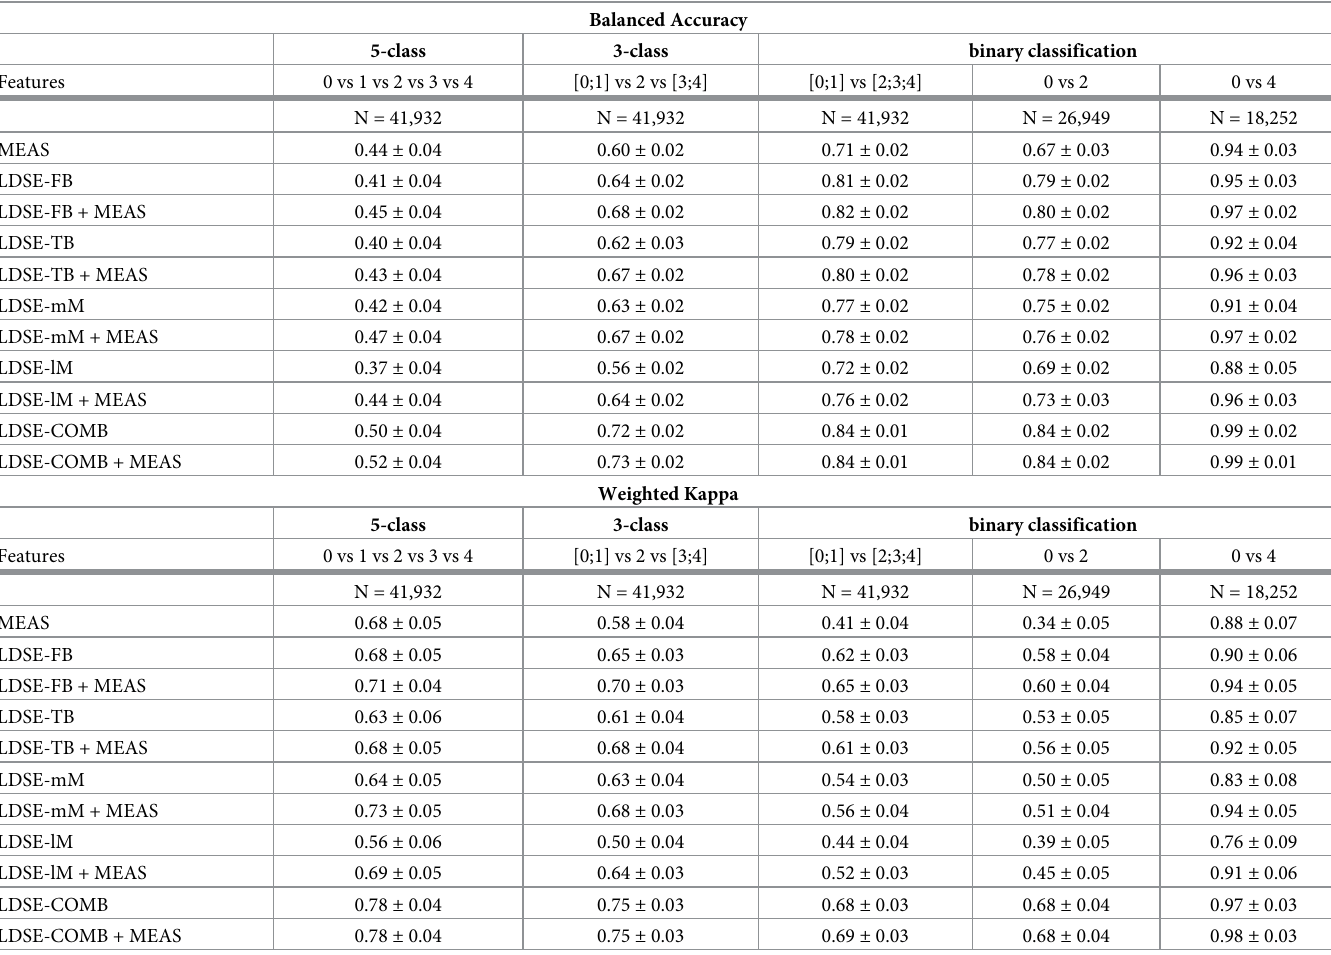
Table 3. Classification of KLG (average over all time points weighted by number of cases).